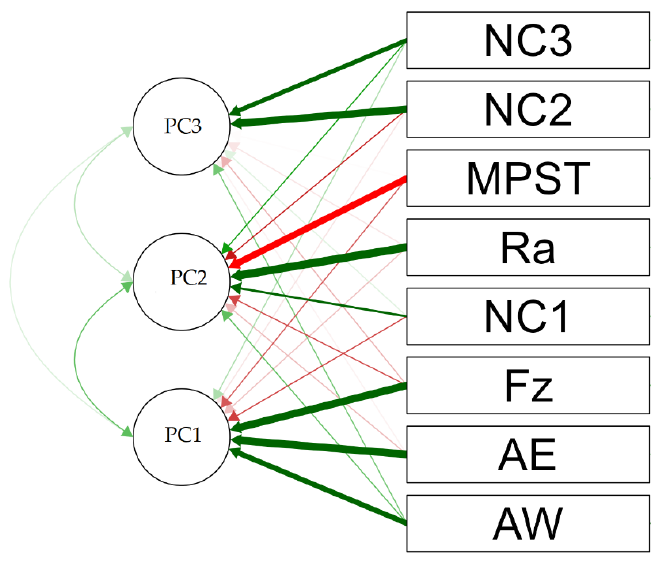
Figure 6. Path diagram for the first three PCs after cluster rotation. PC3 represented the circularity errors at the middle and bottom of the part. Both of